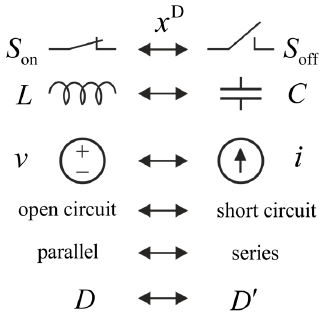
Figure 10. Duality transformation pairs.